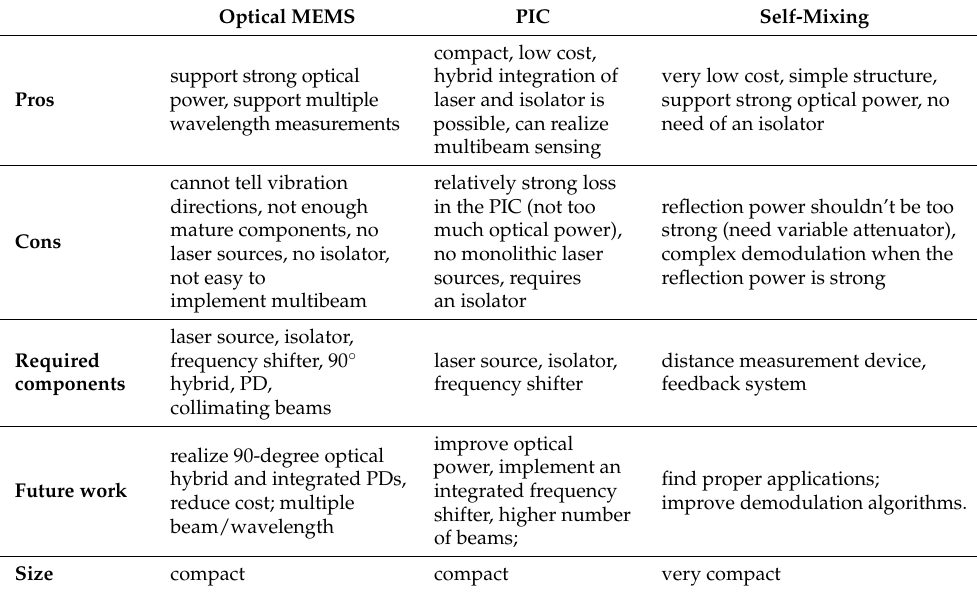
Table 3. Comparison of different technologies for the miniaturization of LDV